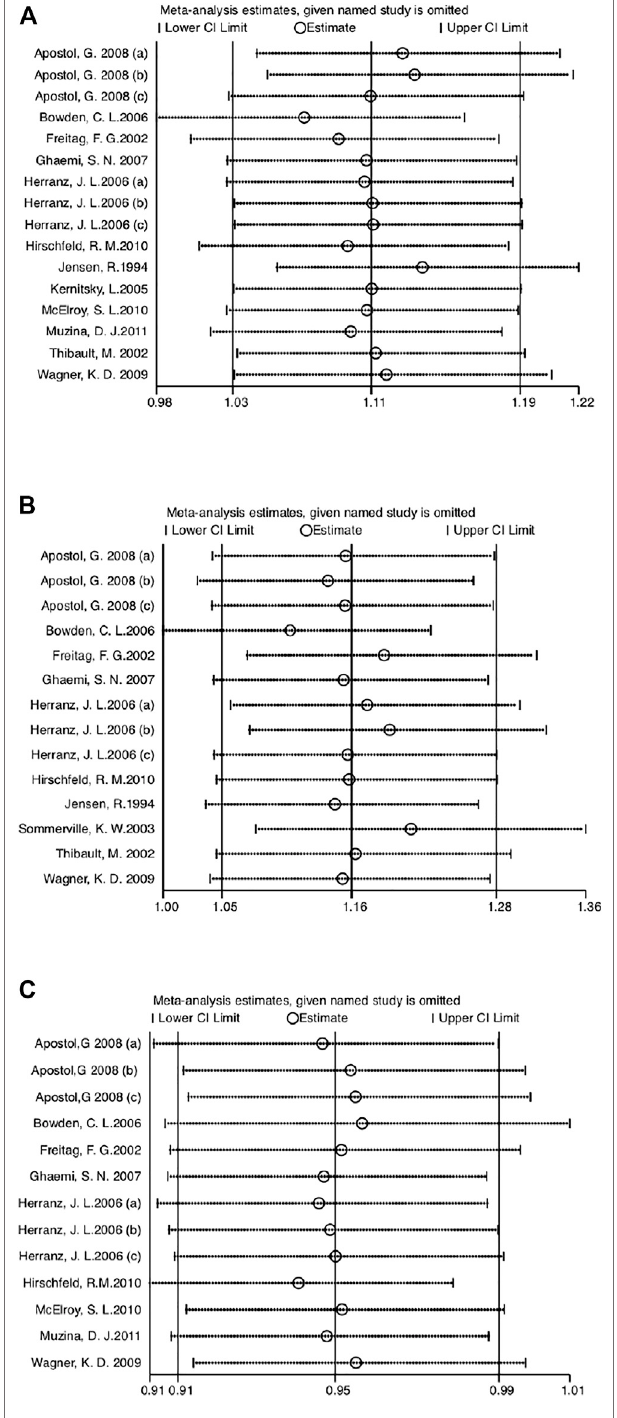
FIGURE 6 | (A) Sensitivity analysis of ef fi cacy compared VPA-ER with control groups. (B) Sensitivity analysis of safety compared VPA-ER with control groups. (C) Sensitivity analysis of retention rate compared VPA-ER with control groups.